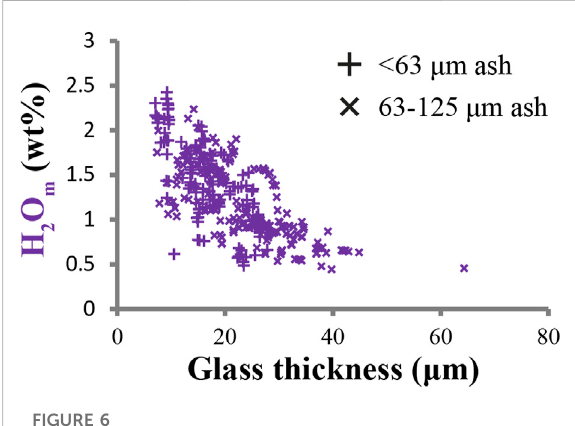
FIGURE 6 FTIRH 2 O m dataforallindividualspectrafromthe < 63 μ mand 63 – 125 µm size fractions. The general trend of higher H 2 O m wt% for thinner glasses is evidence for hydration of tephra by external